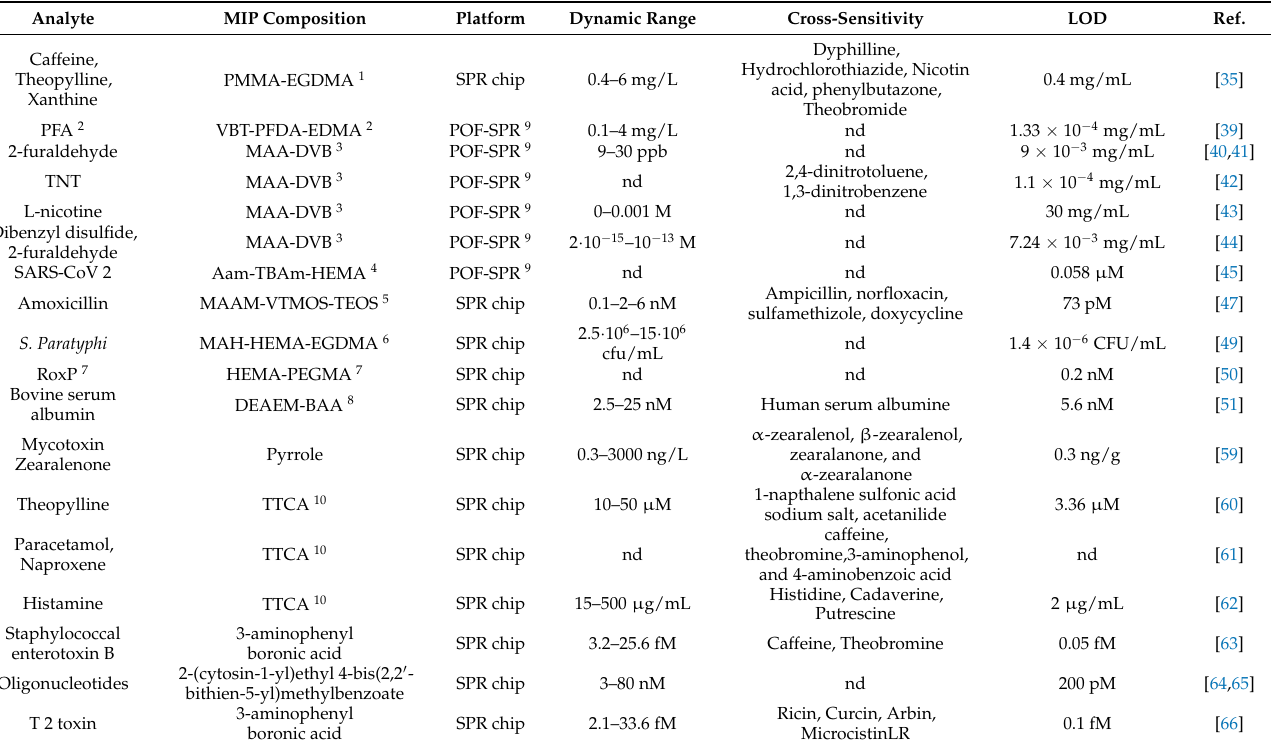
Table 1. Summary of the MIP film-based SPR sensors described in Section